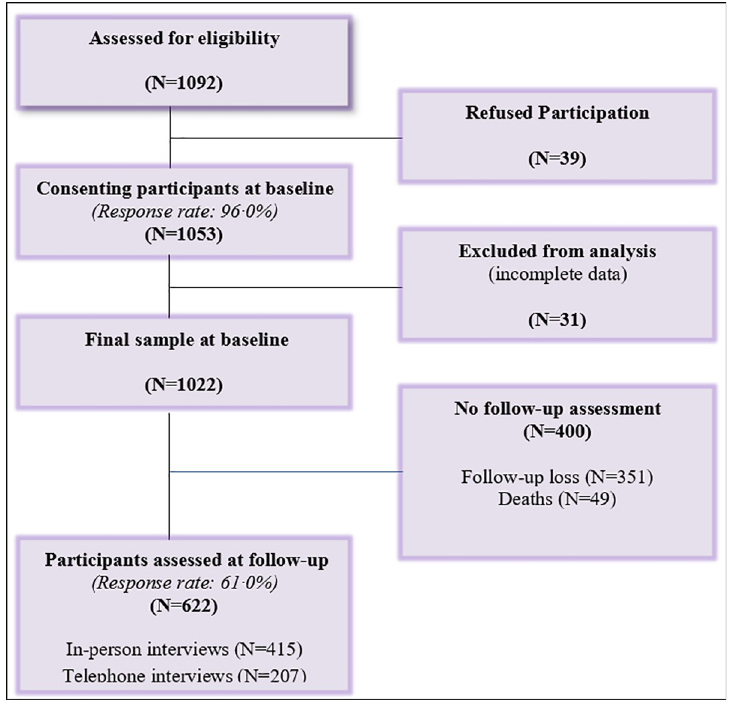
Fig 1. Flowchart from baseline recruitment to longitudinal study